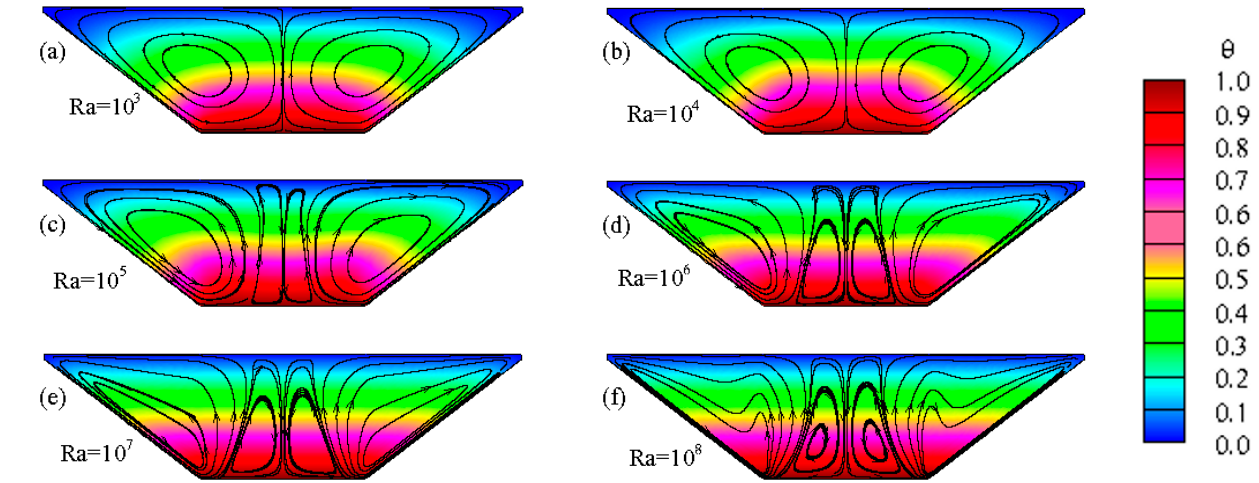
Figure 4. Streamlines and isotherms at the early stage for the different Rayleigh numbers ( a ) Ra = 10 3 , ( b ) Ra = 10 4 , ( c ) Ra = 10 5 , ( d ) Ra = 10 6 , ( e ) Ra = 10 7 , ( f ) Ra = 10 8 , at τ = 6.